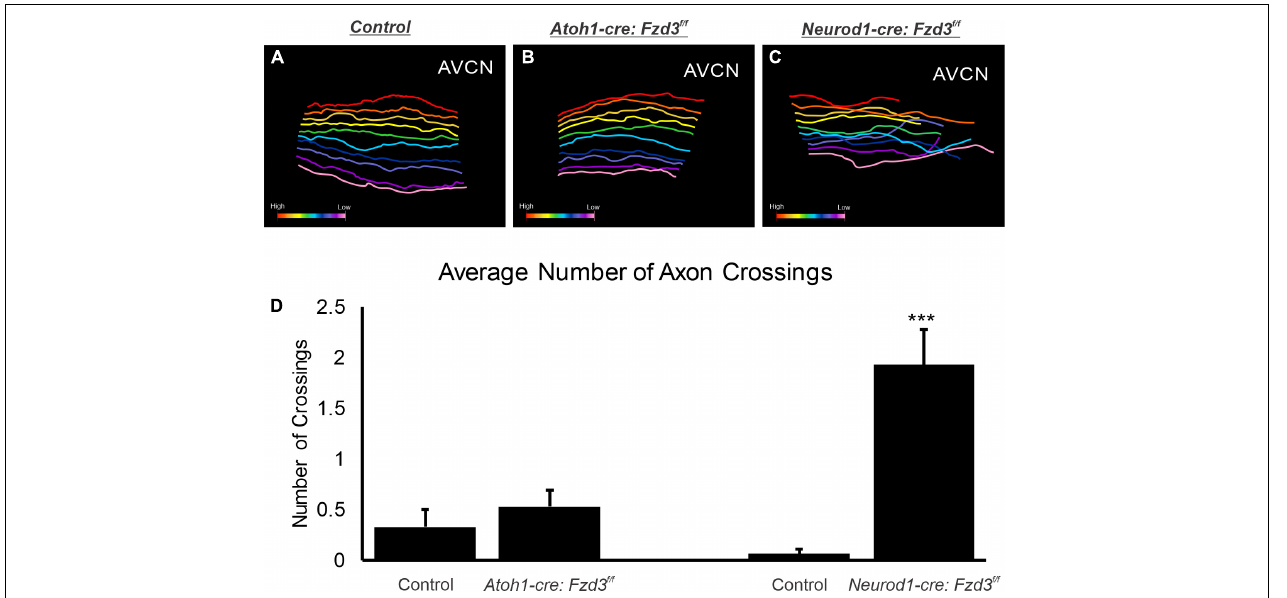
FIGURE 2 | Analysis of cochlear afferent central projections following conditional deletion of Fzd3 . Reconstruction of 10 evenly spaced apical afferents in the AVCN of control (A) , Atoh1-cre:Fzd3 f / f mutant (B) , and Neurod1-cre:Fzd3 f / f mutant (C) . Colored gradient bar represents the transition from higher frequency reconstructed fibers (red) to lower frequency reconstructed fibers (pink) (A–C) . The mean number of times an axon crossed another axon in littermate control and mutant samples (D) . Error bars represent standard error of the mean. *** p < 0.001.